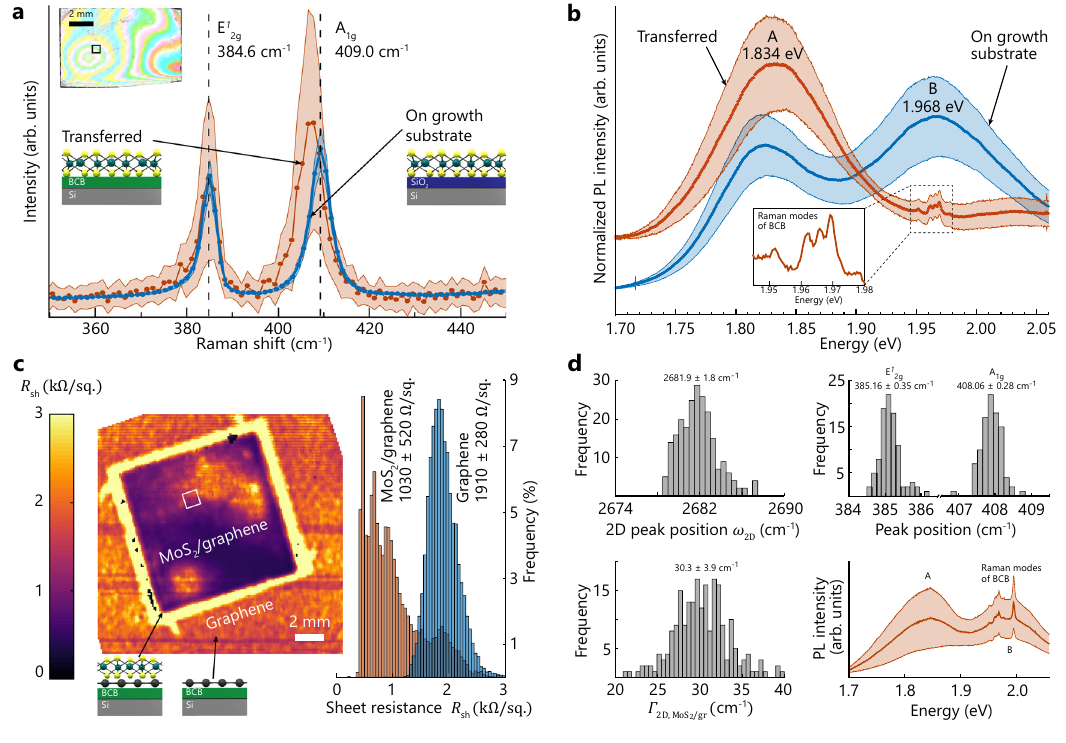
Fig. 4 Transfer and characterization of molybdenum disul fi de (MoS 2 ) and MoS 2 /graphene heterostructures. a Averaged Raman spectra of multilayer MoS 2 on the SiO 2 /Si growth substrate before transfer (blue) and after transfer to the target wafer (red). The Raman spectra are averages of area scans with 8 × 10 measurements in 1 mm 2 areas (black rectangle in the photograph of transferred MoS 2 ) and were normalized to the intensity of the E 1 2g mode. The shaded regions represent the standard deviation of the intensity. The vertical dashed lines indicate the peak positions of the E 1 2g and A 1g modes of the as-grown fi lm before transfer. b Averages of 25 photoluminescence (PL) intensity spectra of pristine (blue) and transferred (red) multilayer MoS 2 with A and B excitonic transitions (shaded areas: standard deviation). The inset magni fi es the region from 1.945 to 1.98 eV and shows the Raman modes of bisbenzocyclobutene (BCB), which are superimposed with the optical response of the MoS 2 layer. c Spatially resolved map (left) and histogram (right) of the graphene sheet resistance ( R sh ) from terahertz near- fi eld spectroscopy (resolution: 300 μ m). The MoS 2 /graphene heterostructure in the center (rectangular region) is surrounded by graphene, both resting on BCB. d Raman and PL spectroscopy of the MoS 2 /graphene heterostructure, measured in a 1 × 1 mm 2 region on the same sample as in panel ( c ) (white rectangle). The Raman peak positions indicate the presence of both MoS 2 (E 1 2g and A 1g peaks) and graphene (2D peak position ( ω 2D ) and the respective full-width at half-maximum ( Γ 2D ; MoS ). The averaged PL spectrum (bottom right) shows the A 2 = gr and B excitonic transitions of MoS 2 and the superimposed Raman modes of BCB (shaded area: standard